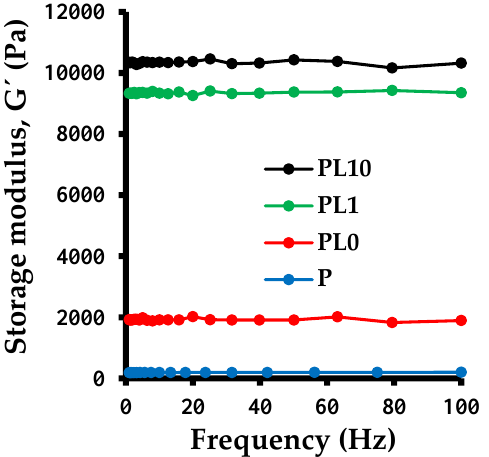
Figure 22. Frequency sweep at constant strain of 2% for hybrid hydrogels with different mass percentage of red mud.